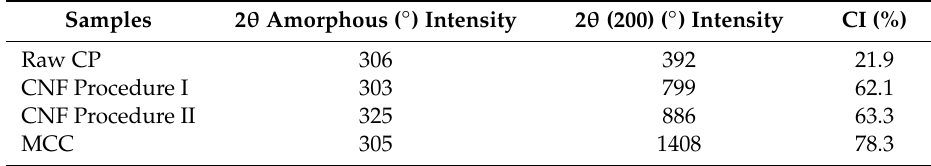
Table 3. Crystallinity index (CI) (%) of raw CP, CNF procedures I and II, and commercial MCC.